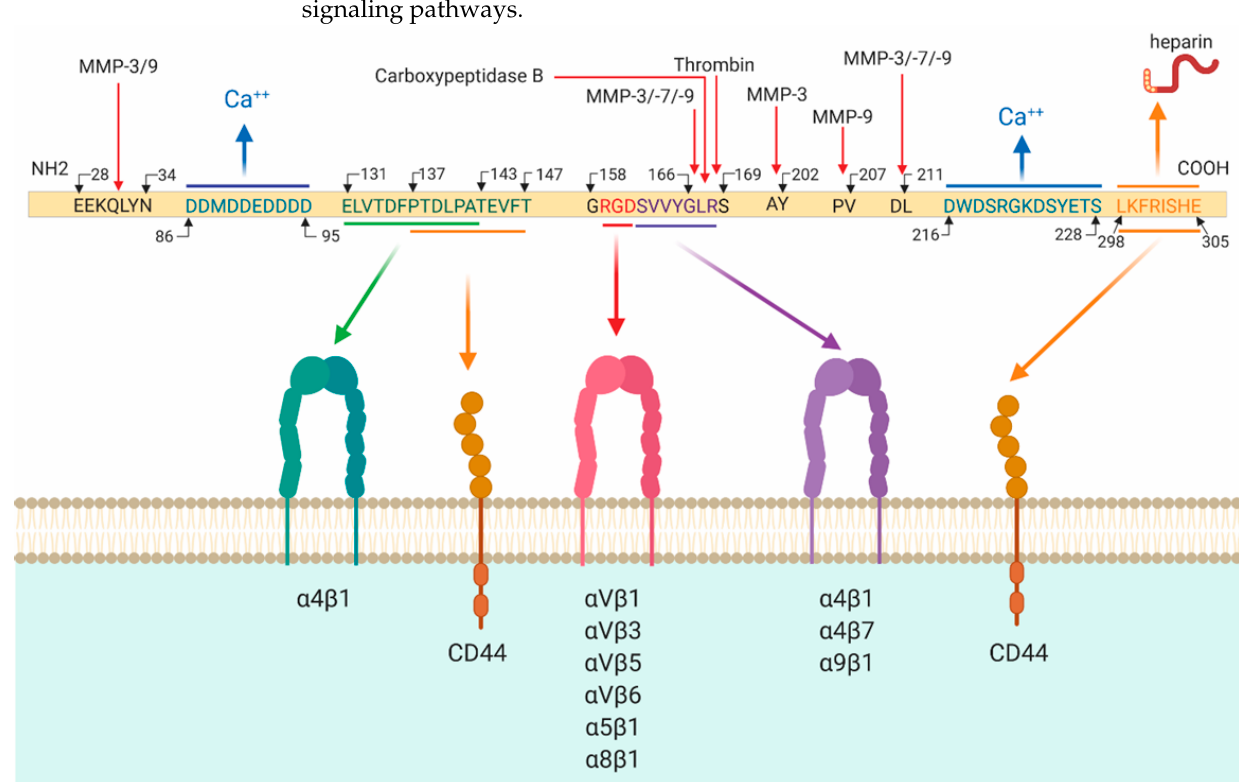
Figure 1. Osteopontin biology. Human osteopontin consists of 314 amino acid residues. Osteopontin can be cleaved at several sites by various proteases including thrombin (between amino acids 168- 169), matrix metallopeptidase 3 (MMP-3) (between amino acids 31–32, 166–167, 201–202, and 210– 2011), MMP-7 (between amino acids 166–167 and 210–211) and MMP-9 (between amino acids